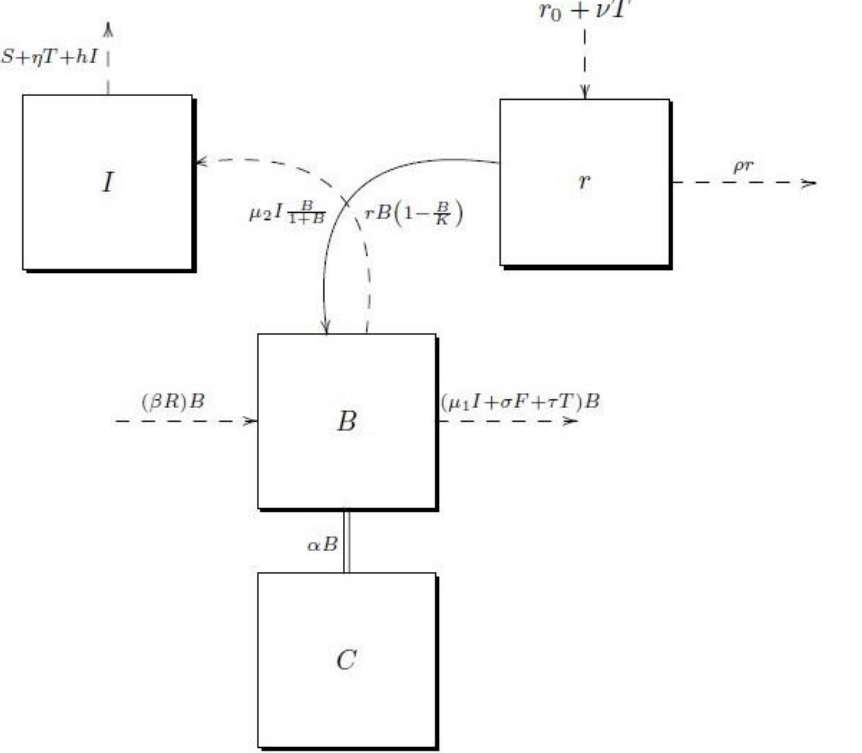
Figure 1. Mathematical model scheme. Dashed arrows indicate positive input and negative output values. The continuous arrow indicates that the term adds to the input variable but does not subtract the output variable. The double solid line represents the observable variable assumed to be proportional to biomass.